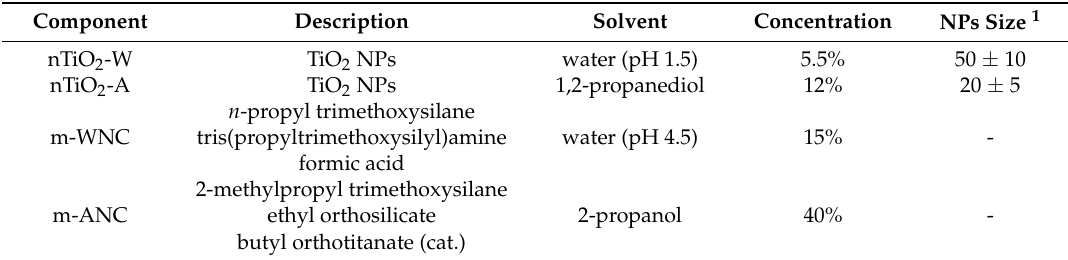
Table 1. Main properties of the components used for the preparation of WNC and ANC, namely TiO 2 NPs (nTiO 2 -W and nTiO 2 -A) and alkylalkoxysilane matrices (m-WNC and m-ANC), as reported by the producers: chemical composition, solvent, concentration ( w / w ) and nanoparticle size (nm). Component